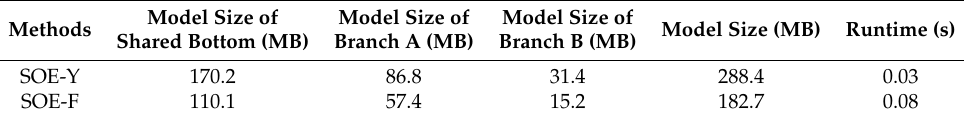
Table 2. Comparison of model size and runtime for SOE-Y and SOE-F. Methods